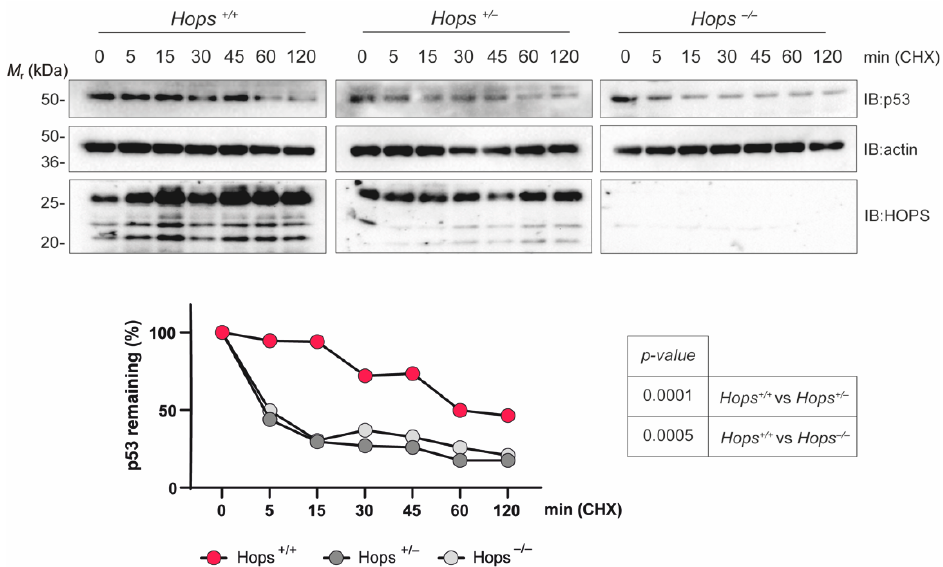
Figure 4. p53 protein stability in MEFs. Hops +/+ , Hops +/ − , and Hops − / − MEFs were subjected to cycloheximide (CHX) treatment. Cycloheximide was added at 100 µ M for the indicated time (h) and p53 survival was analyzed by Western blot analysis (upper panel) and shown as a graph (lower panel). Representative images of three experiments were shown. The p53 protein levels were semiquantified using β -actin as a loading control, and relative p53 levels at time 0 were assumed to be 100% (lower panel). The p -values were calculated by two-way ANOVA followed by Tukey’s multiple-comparisons test and are represented in the table.